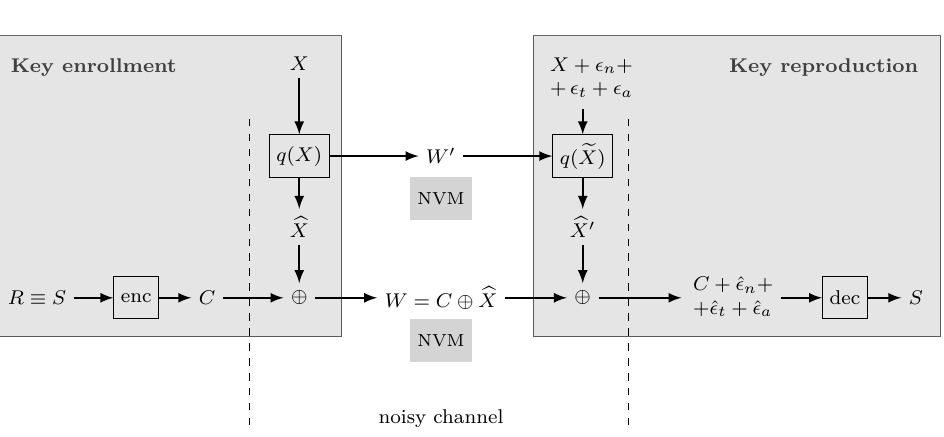
Figure 10: Key generation via Fuzzy Commitment including post-processing and quanti-